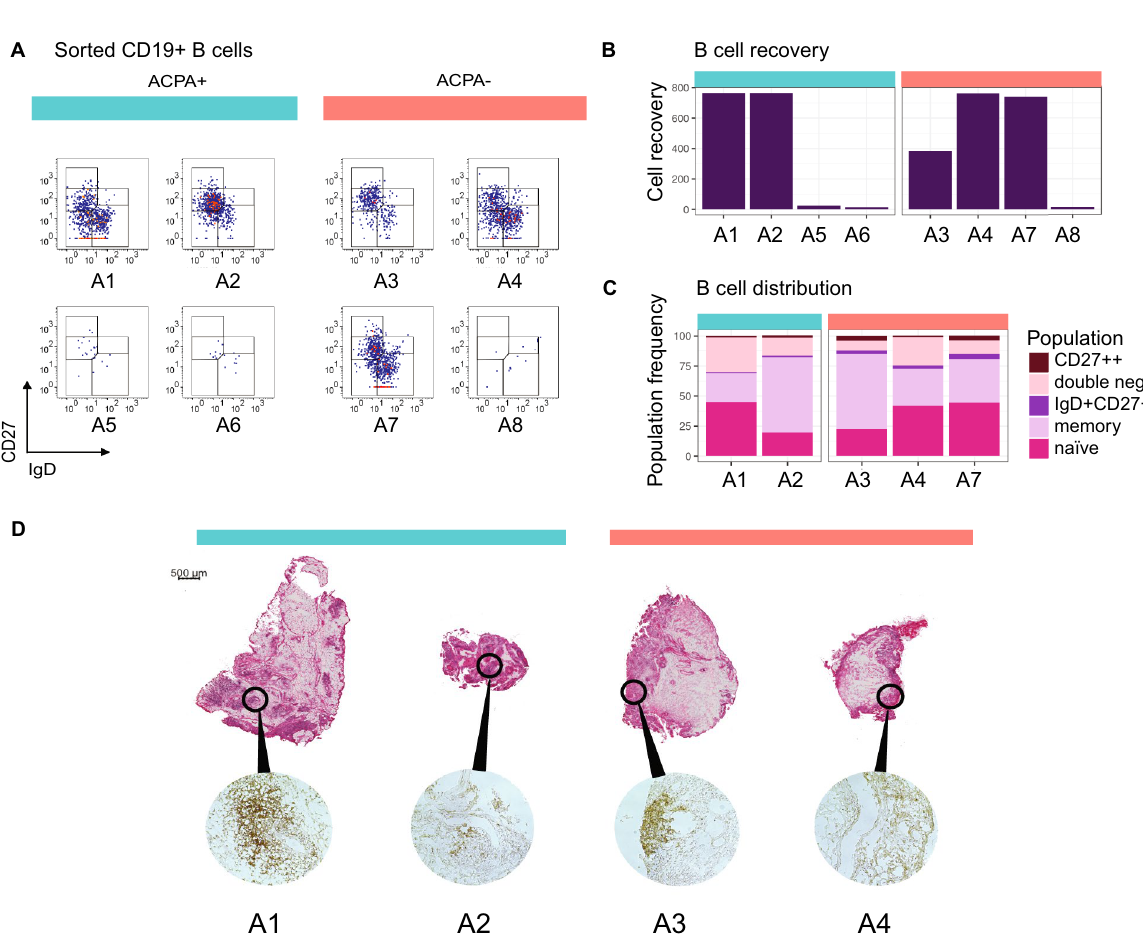
Figure 1. Number, phenotype and spatial distribution of synovial B cells in Rheumatoid Arthritis. ( A ) The flow cytometry panels show all CD3-CD14-AnnexinV-CD19+ single B cells from synovial biopsies of 4 ACPA+ and 4 ACPA− RA patients at the time of diagnosis in pseudocolor plots, where red color indicates data point overlap. A5 was taken from a metacarpophalangeal (MCP) 4 joint, A6 and A7 were taken from wrists. Remaining synovial biopsies are arthroscopic biopsies from knees. ( B ) 5 out of 8 biopsies exceeded a minimum of 382 B cells suitable for phenotypic characterization and scRNAseq analysis. ( C ) Memory B cells made up the largest population of synovial B cells (24–63%), while naïve cells were a bit fewer (20–45%). Double negative B cells had a variable range (8–29%), while a minority was CD27++ (1–4%) or of the unswitched IgD+ CD27+ memory phenotype (2–4%). ( D) H&E-staining shows the tissue architecture of A1–A4. Immunohistochemistry staining with anti-CD19 and anti-CD20 antibody cocktail confirms the presence of B cells. ACPA+ samples are indicated by turquoise color, and ACPA− in